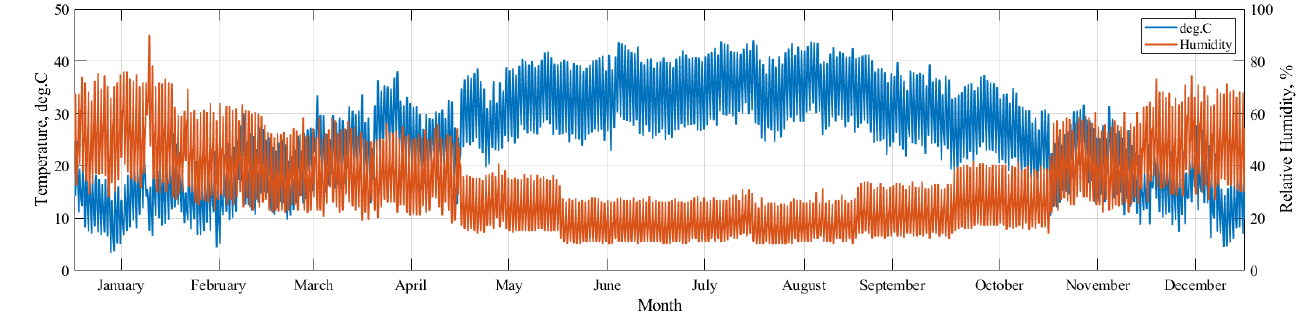
Figure 7. Ambient temperature and relative humidity for Riyadh, KSA generated with data from